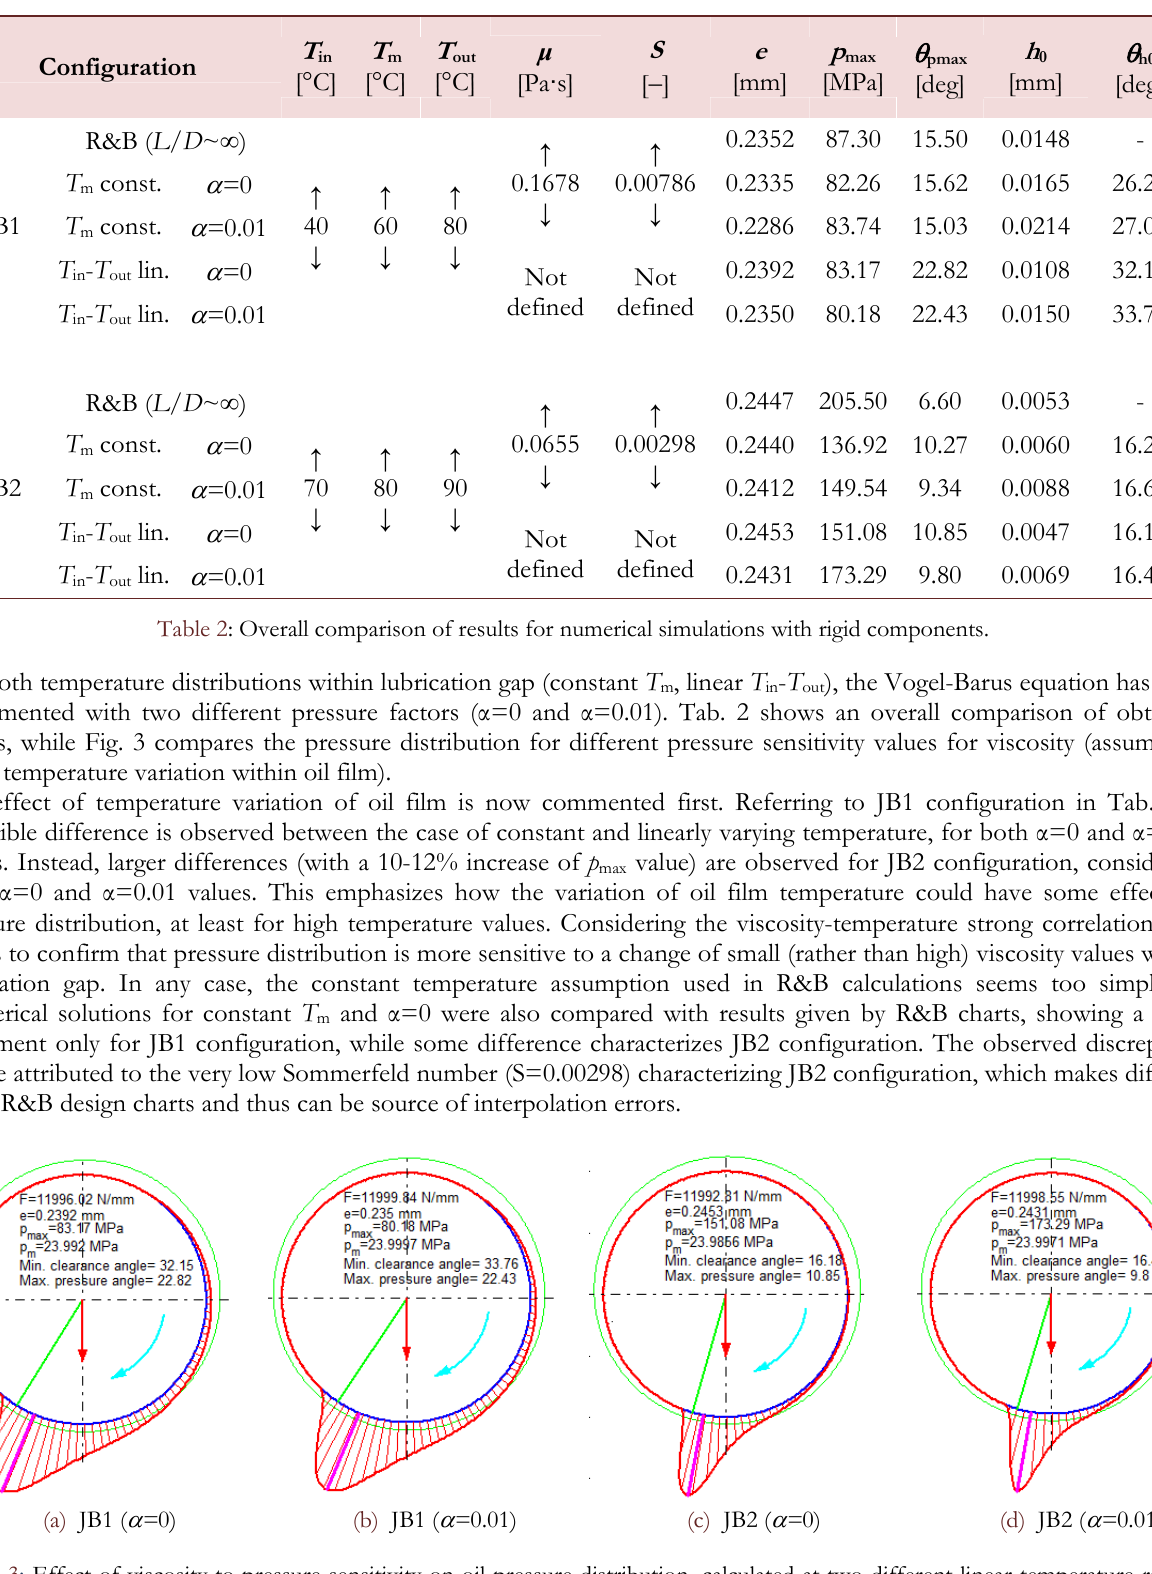
Figure 3: Effect of viscosity-to-pressure sensitivity on oil pressure distribution, calculated at two different linear temperature